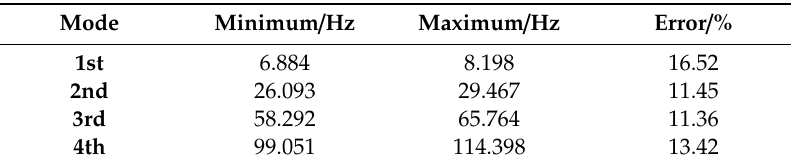
Table 1. The maximum and minimum natural frequencies.